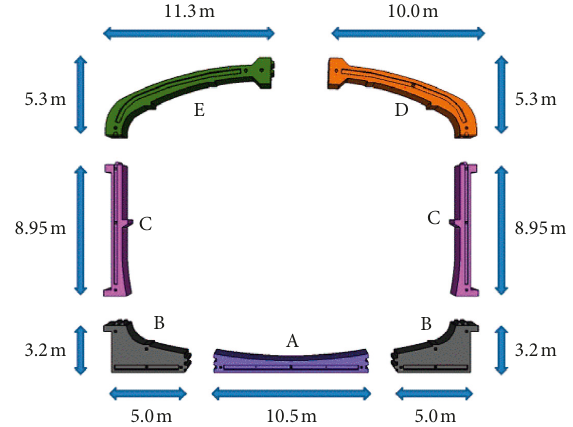
Figure 2: Geometry of a Changchun Line 2 station prefabricated element.